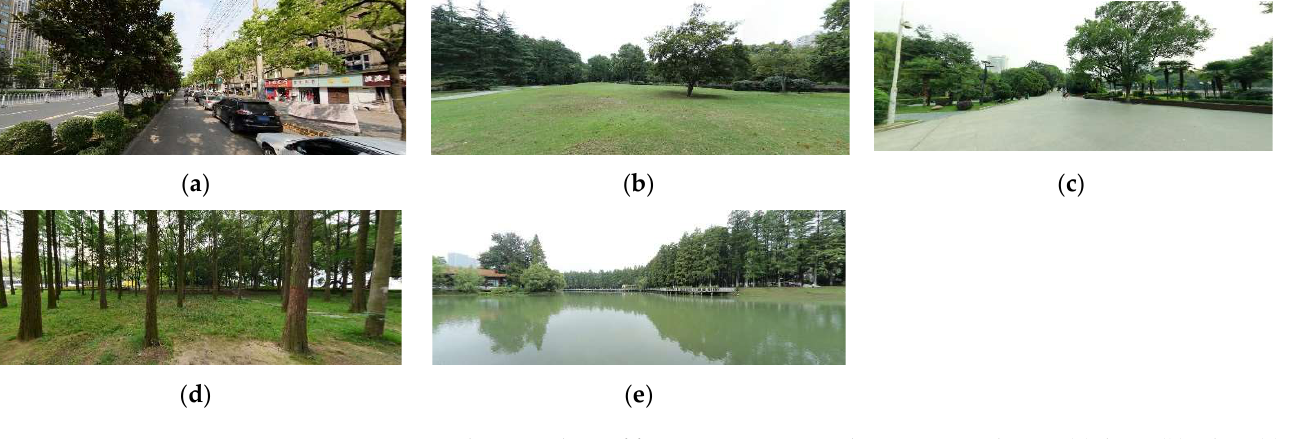
Figure 1. Example screenshots of five environment conditions: greened street ( a ), lawn ( b ), plaza ( c ), forest ( d ), and waterside ( e ).